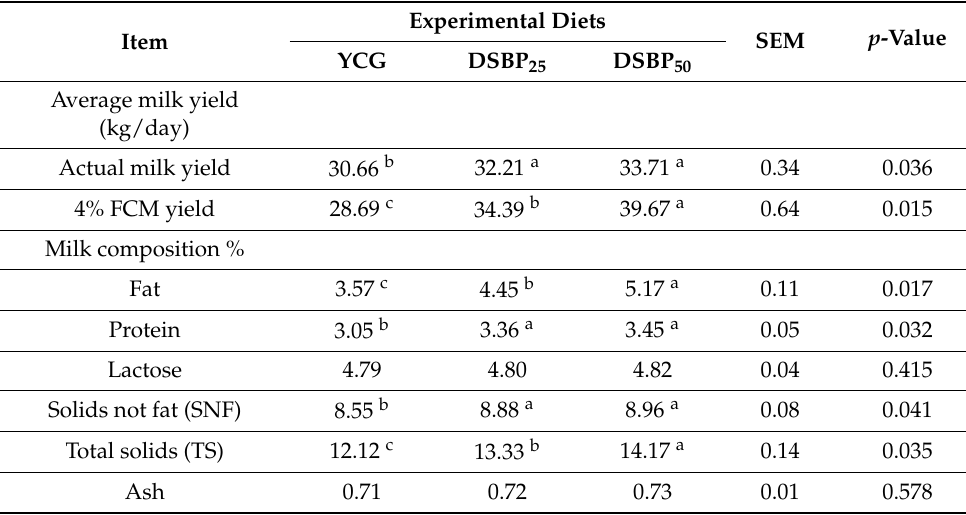
Table 8. Milk yield and its composition for cows fed experimental rations.